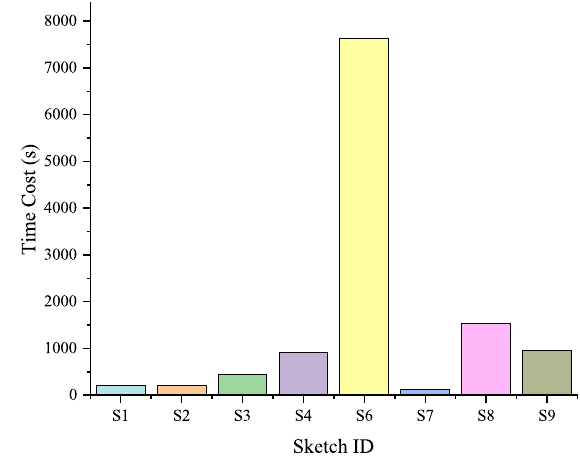
Figure 18. Time cost for roads matching in each